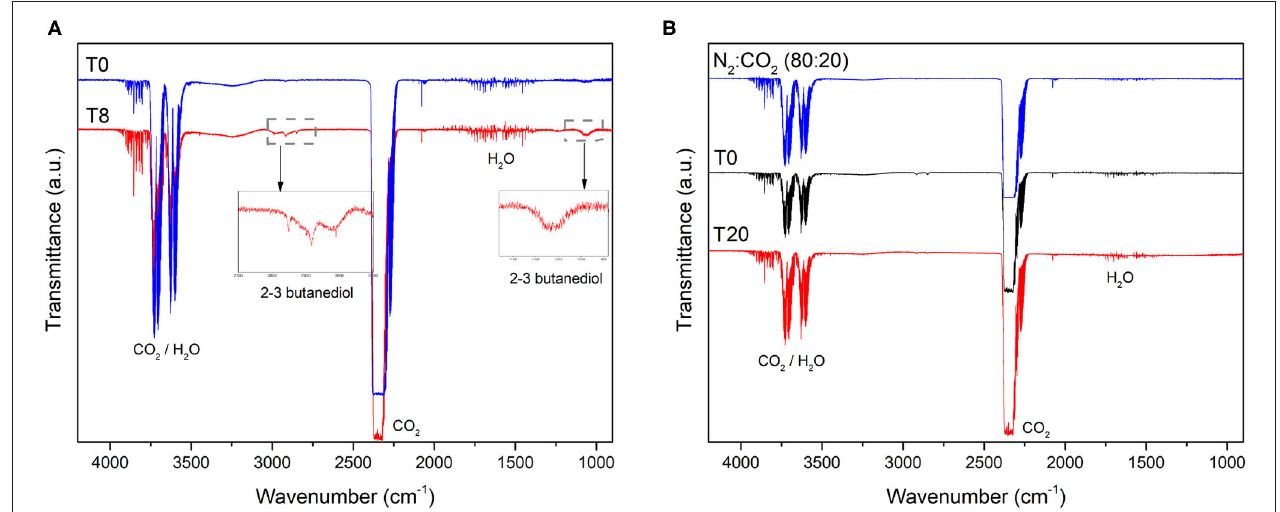
FIGURE 3 | Gas composition of the (A) enrichment vial and (B) MEC-a head-space determined by Fourier Transformed Infrared Spectroscopy (FTIR). The enrichment vial was sparged with N 2 :CO 2 (80:20) at T0 and then inoculated with the river sediment. A gas sample was collected from the head-space 8 days after inoculation (T8). MEC-a was inoculated with the “enrichment” culture after 12 days of incubation of the vial as described in section 2. The MEC was kept in anaerobiosis by sparging with N 2 :CO 2 (80:20, blue line in B ). The working electrode of MEC-a was poised at +240 mV vs. Ag/AgCl at T0. Gas samples were collected from the MEC head-space every 48 h. Considering that no differences were observed from day 0 (T0) of MEC operation, only T0 and T20 are shown for clarity purposes. The spectrum of MEC-b and MEC-c were similar to that of